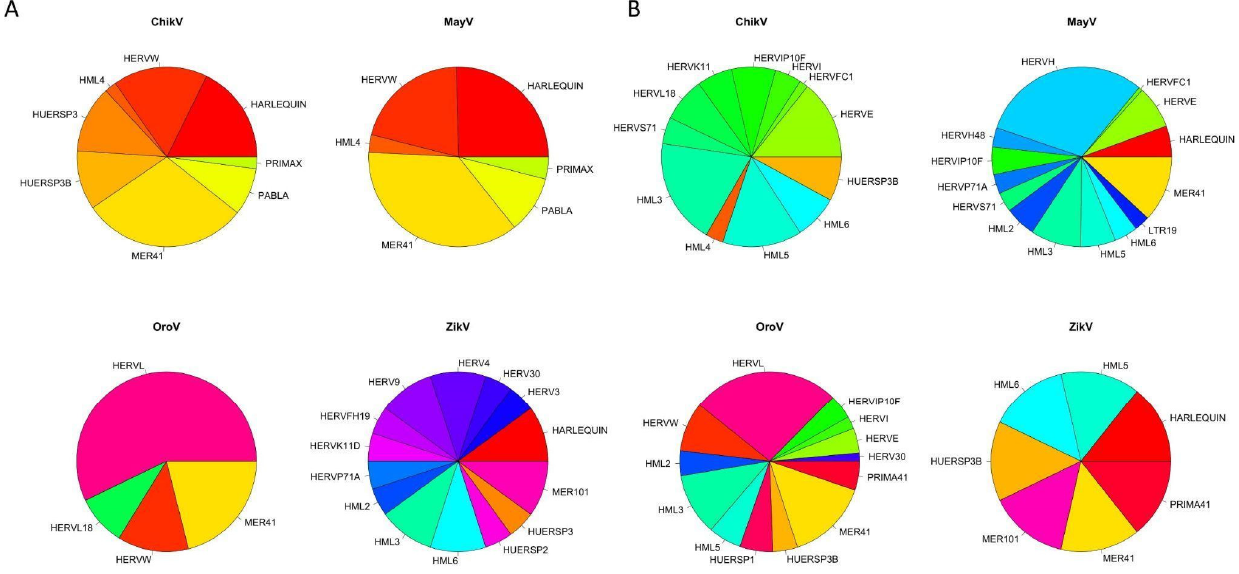
Figure 2. Enriched families of the differentially expressed HERVs by the arboviruses (ChikV, MayV, OroV, and ZikV). ( A ) Upregulated and ( B ) downregulated HERVs families. The similarity between the ChikV and MayV results becomes even clearer when we look for the enriched HERV families, especially regarding the upregulated ones (Figure